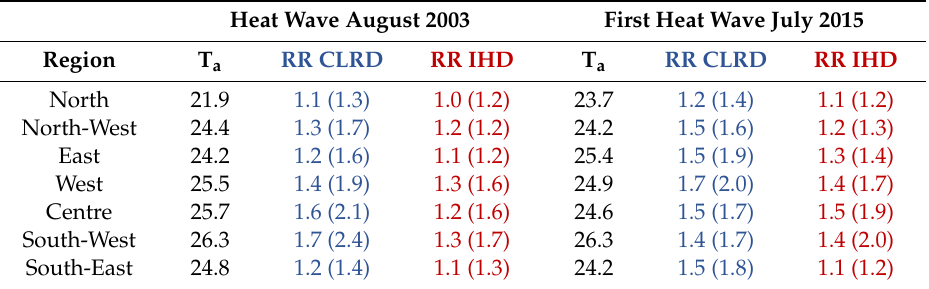
Table 5. Average two-daily T a ( ◦ C) as well as mean (max) of RR of CLRD (blue) and IHD (red) mortality during the heat waves of August 2003 and first part of July 2015 in seven regions in